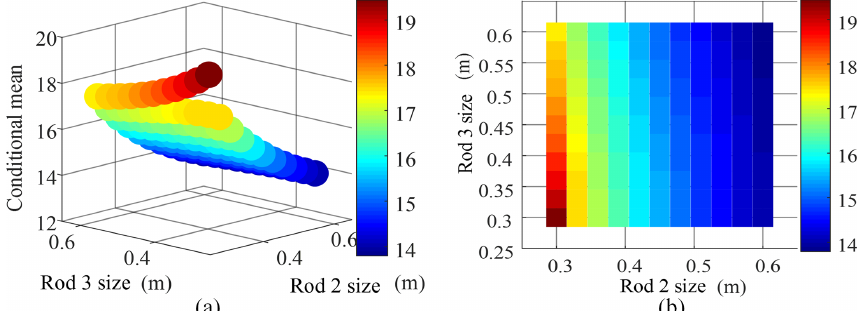
Figure 7. Effect of bar size on mean of spatial condition number. (a) The effect of rod 2 and rod 3. (b) The top view of the effect of rod 2 and rod 3.